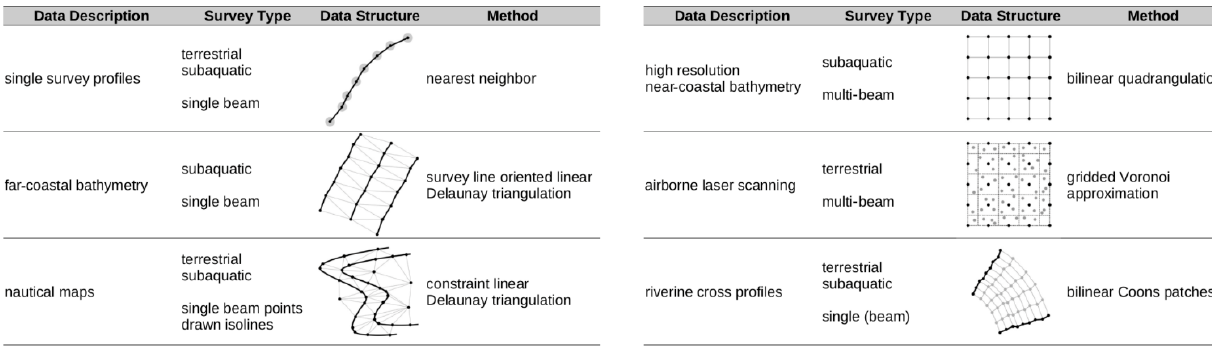
Figure 3. Overview of the most common approximation and interpolation methods used for datasets of the